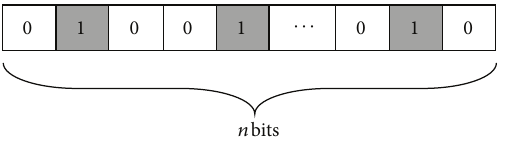
Figure 3: The binary coding